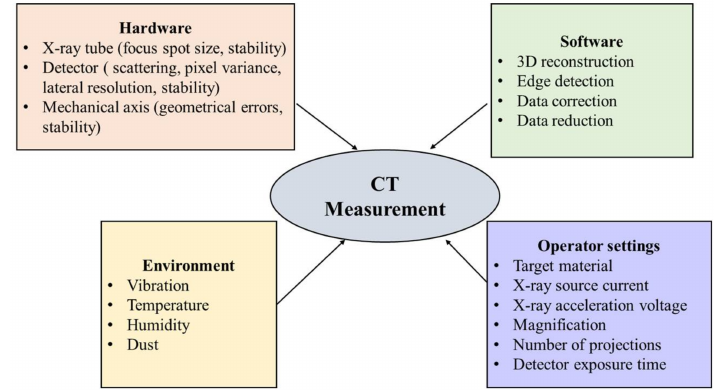
Figure 3. Influence factors for CT measurement.